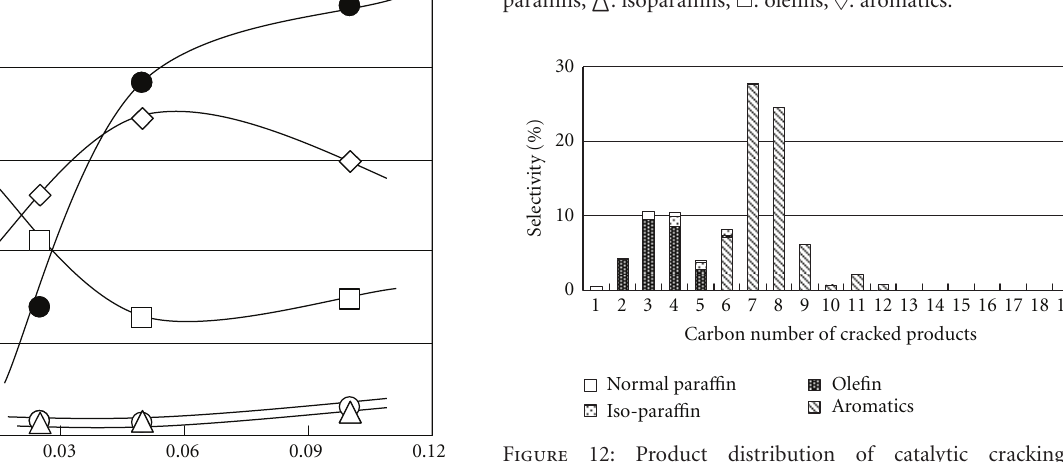
Figure 11: Conversion and product selectivity of catalytic cracking of hydrotreated oil over ns Al 2 O 3 /H-GaAlMFI catalyst depending on reaction temperature. (cid:2) : Conversion; selectivity: (cid:4) : normal (cid:2) para ffi ns; : isopara ffi ns; (cid:2) : olefins; ♦ : aromatics.